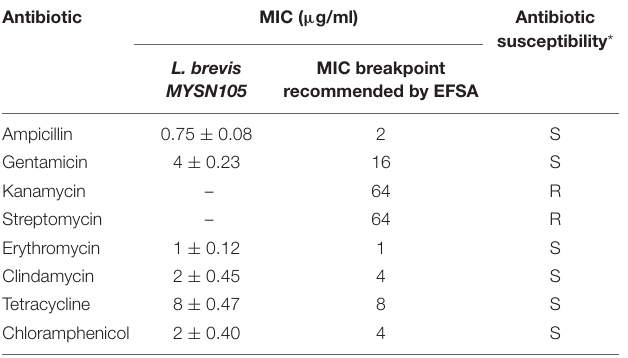
FIGURE 2 | Growth kinetics (circle) and acidification profile (square) of L. brevis MYSN105 in MRS broth at 37 ◦ C for 24